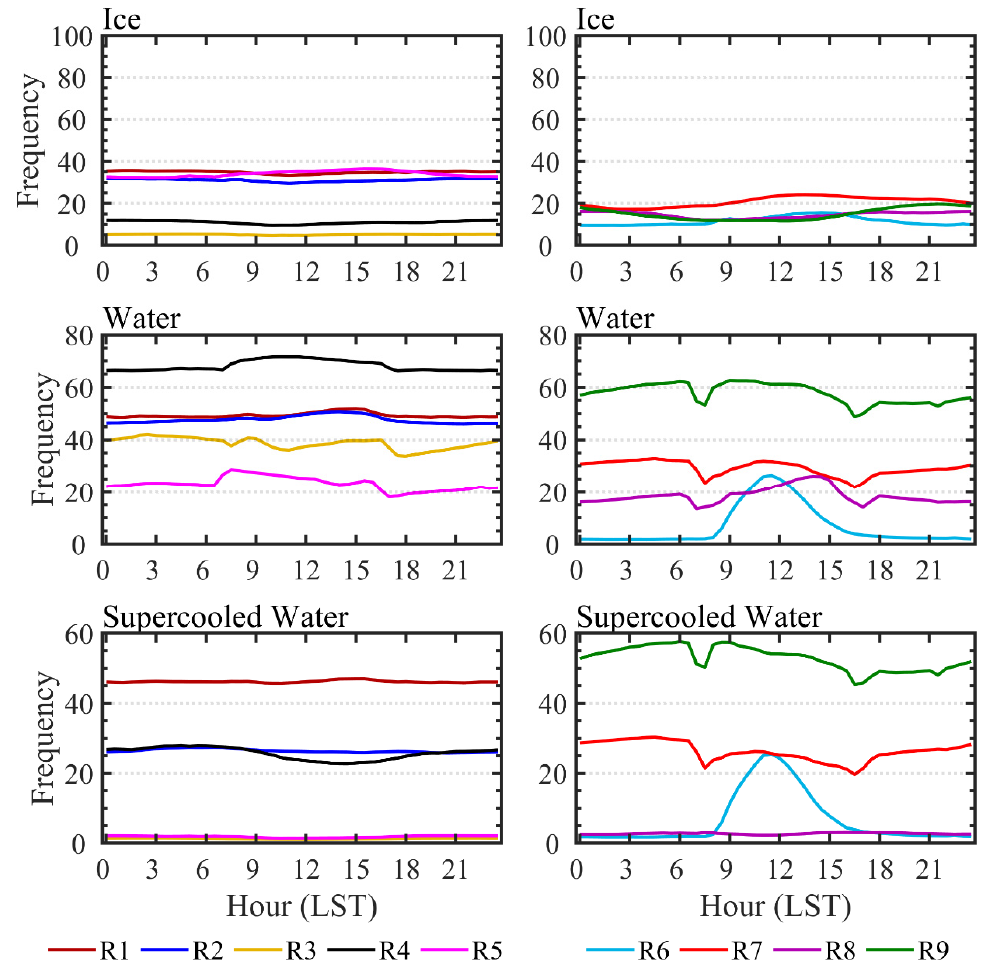
Figure 12. Same as Figure 11 except for the 3-year boreal winter.